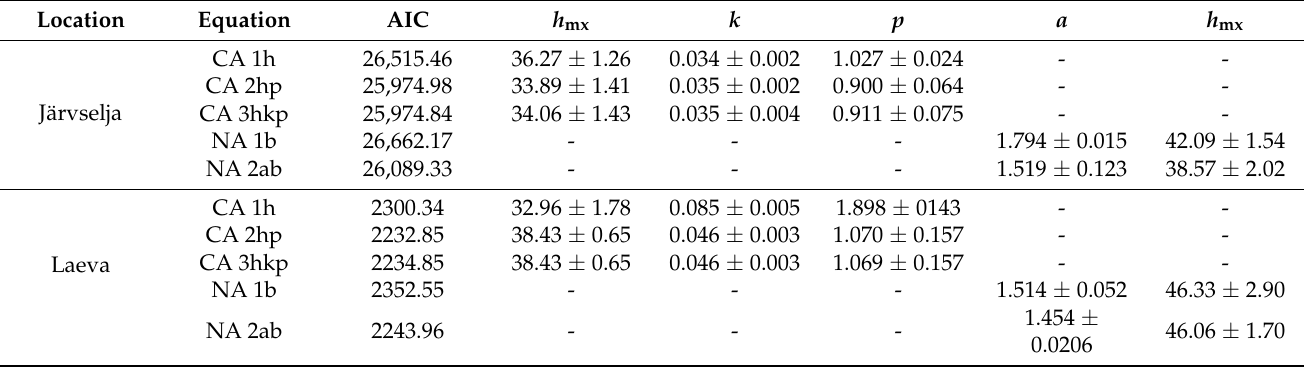
Table 2. Akaike’s information criterion (AIC) and coefficients for the modeled height–diameter (H-D) relationships. Chapman–Richards models (CA) 1–3 and Näslund models (NA) 1–2 describe the different levels of influence of the random effect “species” on the parameters of the fixed-effect models. Parameters are given as value ± standard deviation. Details on the random effects are given in the supplemental